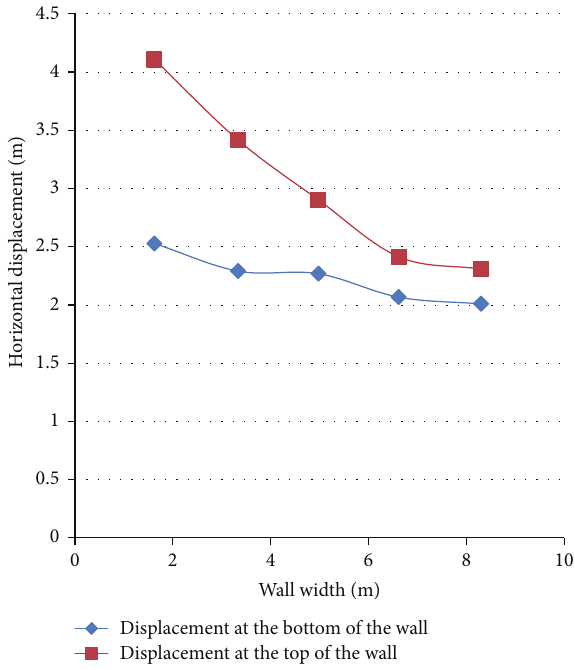
Figure 6: Diagram of the changes in horizontal displacement of the wall versus the width of the wall.